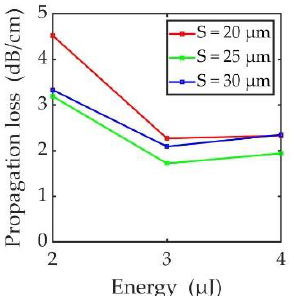
Figure 9. Propagation loss of waveguides fabricated at different pulse energies and track separation, for a scanning speed equal to 100 μm/s.